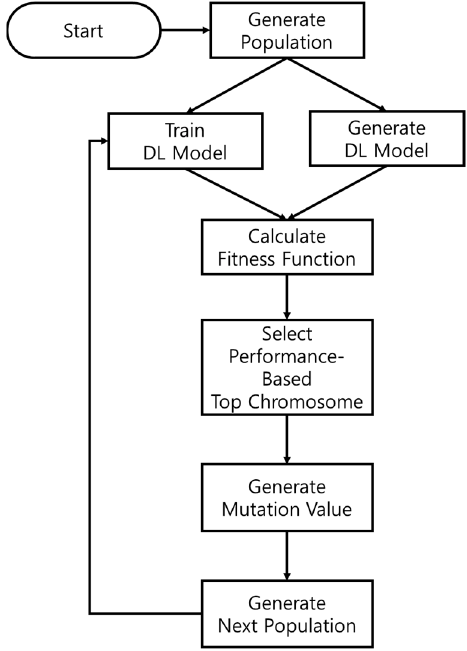
Figure 3. Genetic-algorithm-based optimization process. Table 2. LSTM gene: hyper-parameters. Table 1. RNN gene: